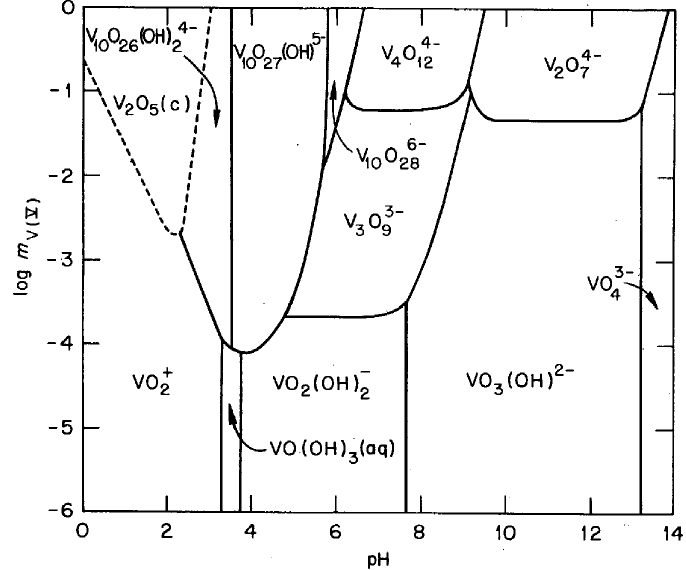
Figure 1. Predominance diagram for V 5+ –OH − species at 25 °C [22]. The solid lines represent conditions under which the predominant species in adjacent regions contain equal amounts of V 5+ . The dashed lines represent the solubility of V 2 O 5 in terms of the V 5+ concentration. m V(V) : moles of V 5+ per kg of water. (Reprinted with permission from “The Hydrolysis of Cations”, Copyright (1976) John Wiley & Sons).